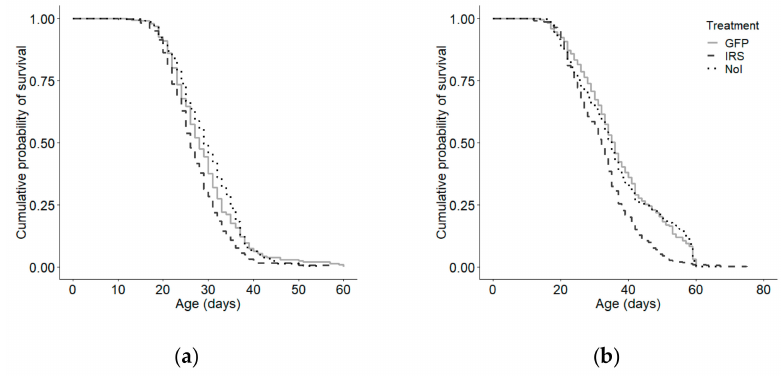
Figure 5. E ff ect of irs knockdown on total lifespan for all bees by host colony. ( a ) irs knockdowns (IRS) foraged earlier than injected controls (GFP: Kaplan–Meier: χ 2 = 17.1, p = 0.0001 n = 857, Cox–Mantel: p = 0.0041). There was no e ff ect of handling stress when the GFP group was compared with the non-handled reference group (NoI: Cox–Mantel: p = 0.37). ( b ) The same pattern was observed in colony 2 (Kaplan–Meier: χ 2 = 34.4, p < 0.0001, n = 1114, Cox–Mantel: IRS vs GFP p = 0.001, GFP vs NoI p = 0.73).